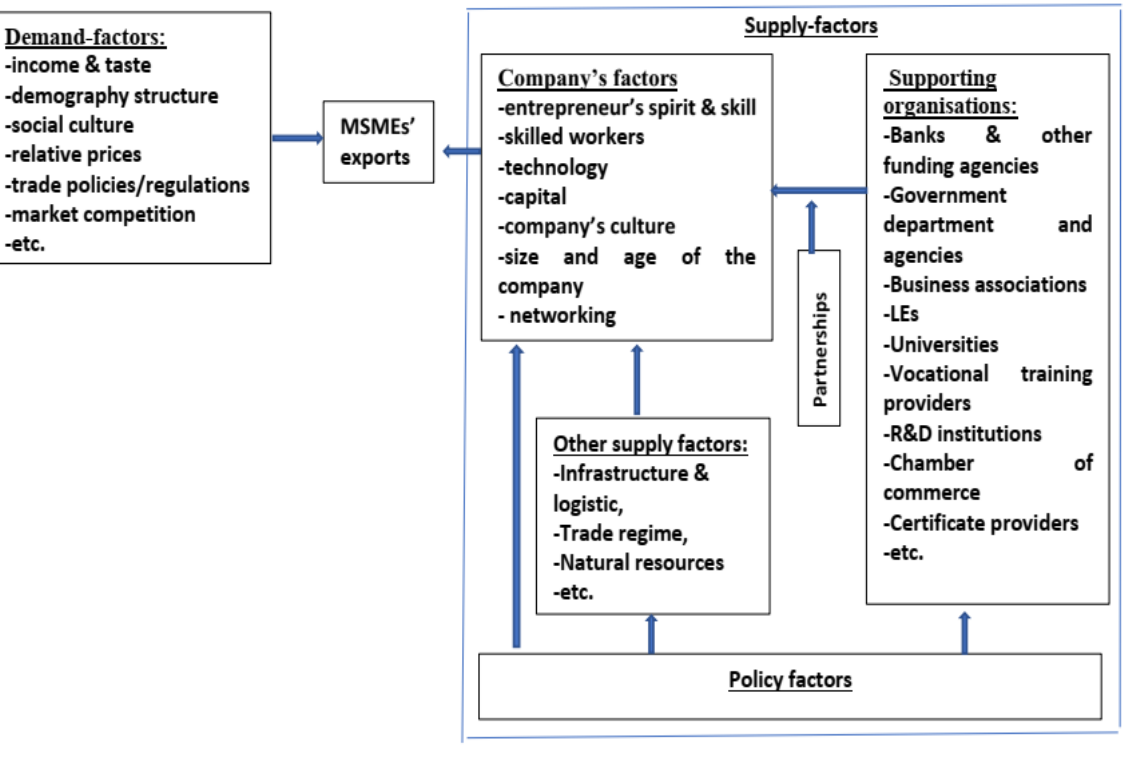
Figure 3: Demand and Supply Determinants of MSMEs’